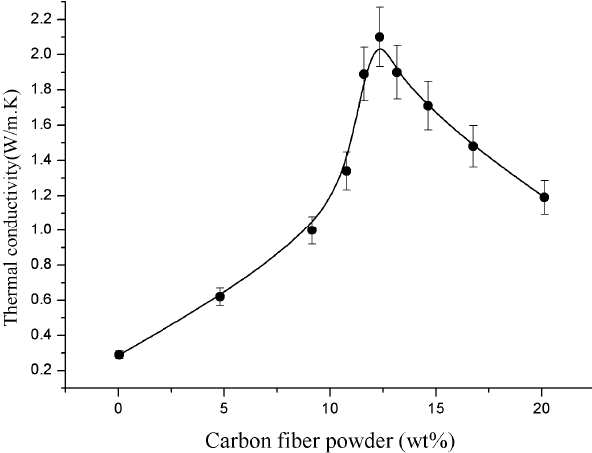
Figure 2. The relationship between the thermal conductivity and CF mass fraction of coating.